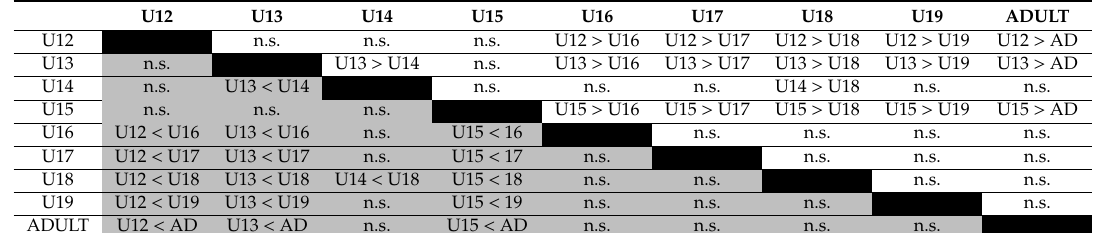
Figure 3. Di ff erences in fat mass among di ff erent age groups. Figure 3. Differences in fat mass among different age groups. Table 3. Bonferroni post-hoc analysis for fat mass and fat-free mass (white background, fat mass; grey background, fat free